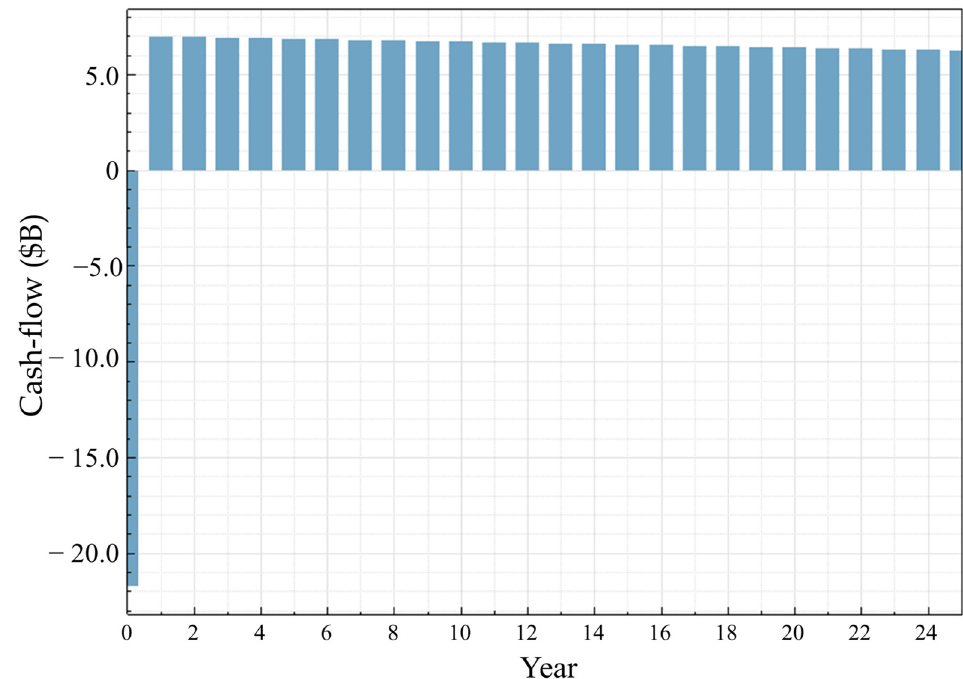
Figure 5. Cash flow in Scenario E. The project starts in 2030: the first negative bar indicates the capital cost, while the horizontal axis represents the year of the project period.